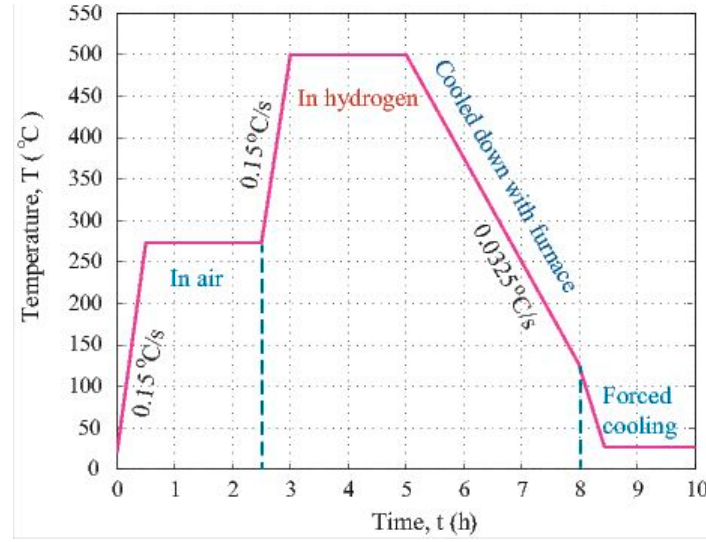
Figure 1. Temperature vs. time profile for heat treating the particle loaded fibers.